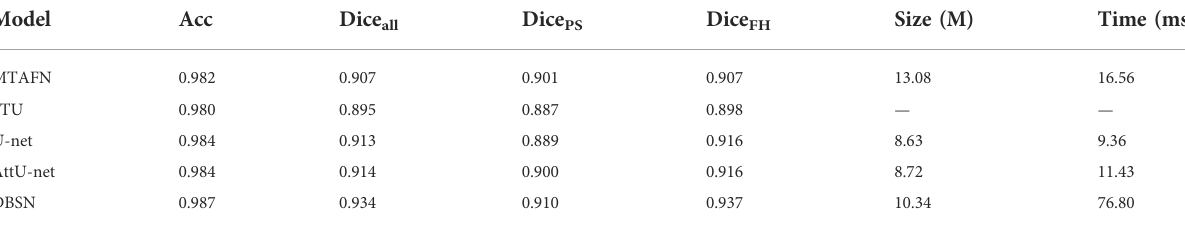
TABLE 1 Comparison of segmentation results of different algorithms.